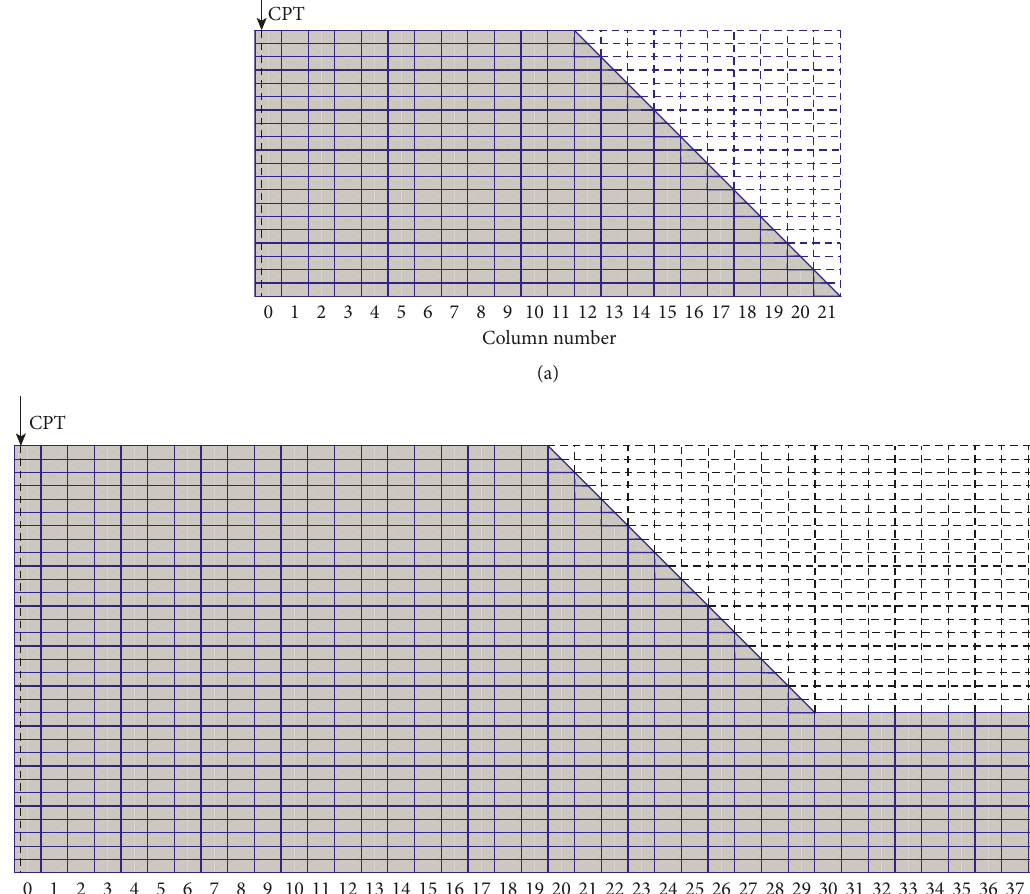
Figure 6: Finite element meshes and a series of numbered CPT locations for a slope cut problem (a) without and (b) with a foundation layer (dashed lines above the slope face indicate the excavated soil mass, numbers at the bottom of each mesh correspond to Gauss point locations within the corresponding column of finite elements, and an example CPT sample at location i � 0 is